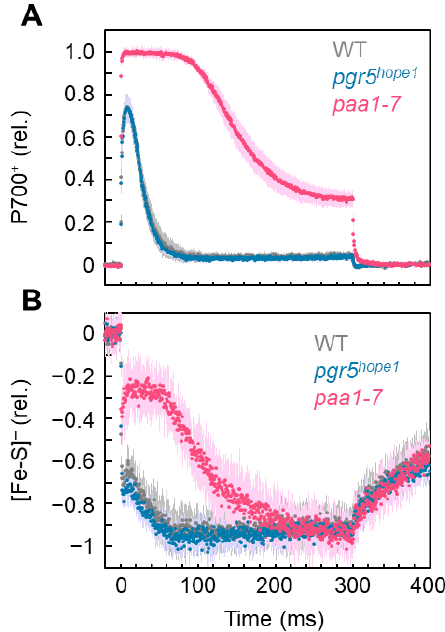
Figure 1. Kinetics of ( A ) oxidized P700 (P700 + ) and ( B ) reduced Fe/S signals (Fe/S − ) in response to short-pulse light for wild-type (WT), pgr5 hope1 , and paa1-7 Arabidopsis intact leaves. Short-pulse light (15,000 µmol photons m − 2 s − 1 , 300 ms) was started at 0 ms. The redox reactions of both P700 and Fe/S were monitored simultaneously. Relative values of both P700 + and [Fe/S] − were normalized to the maximum oxidation and reduction levels, respectively, as described in the “Materials and Methods”. The negative values of Fe/S − show the reduction of Fe/S. The data points for WT (gray), pgr5 hope1 (magenta), and paa1 - 7 / pox1 (red) are the means of six biological replicates (darker color) and the shadowed area is the standard deviation (lighter color).